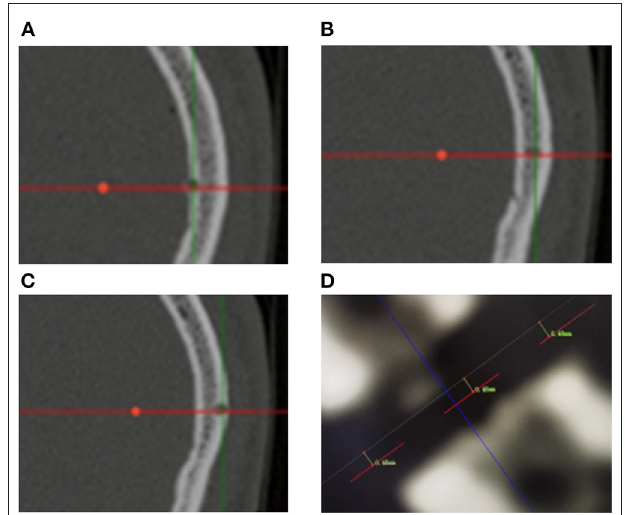
FIGURE 3 | (A–C) Measurement of entry point error based on postoperative CT scanning. The red lines represent the biopsy trajectory planned preoperatively. Bone defects represent the actual biopsy trajectory of the operation. The EPEs are computed as the average of the measurement of the inner part, midpoint and outer part of the cranial bone. (D) The picture shows the measurement results of one of the patients. The EPEs were 0.48, 0.48, and 0.49mm, respectively.